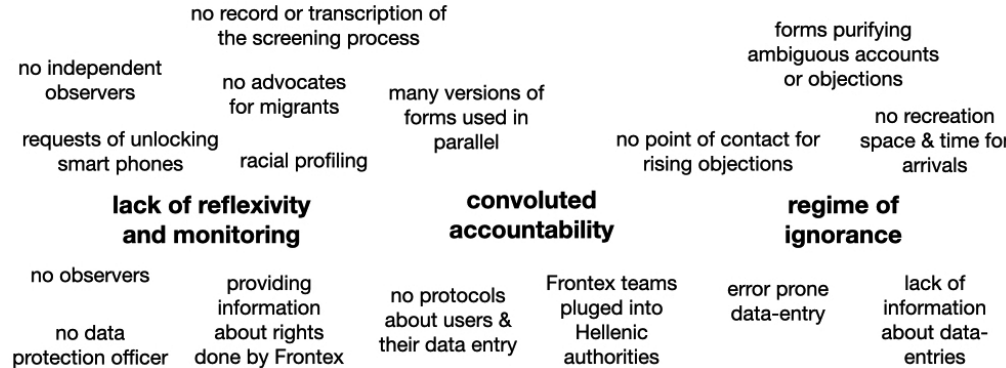
Figure 5. Issue map of the Registration and Identification Centre Moria. Within institutional ecologies of border control, which is better characterised by secrecy, barriers and caution than by public debates and controversies, a discourse analysis is difficult to conduct. But Clarke also stresses to be sensitive to the issues which are somehow there but remain absent, as well as to look out for contradict- ing accounts and positions actors that are articulating (Clarke, 2005, p. 129). This might be a more suitable starting point for a critical approach of issue mapping that focuses on power relations and conditions of gov- erning and produces silenced, invisibilized and othered voices and positions. In the following, I will articulate dif- ferent issues by interrelating and generalizing topics that came up throughout the inquiry and the different map- ping